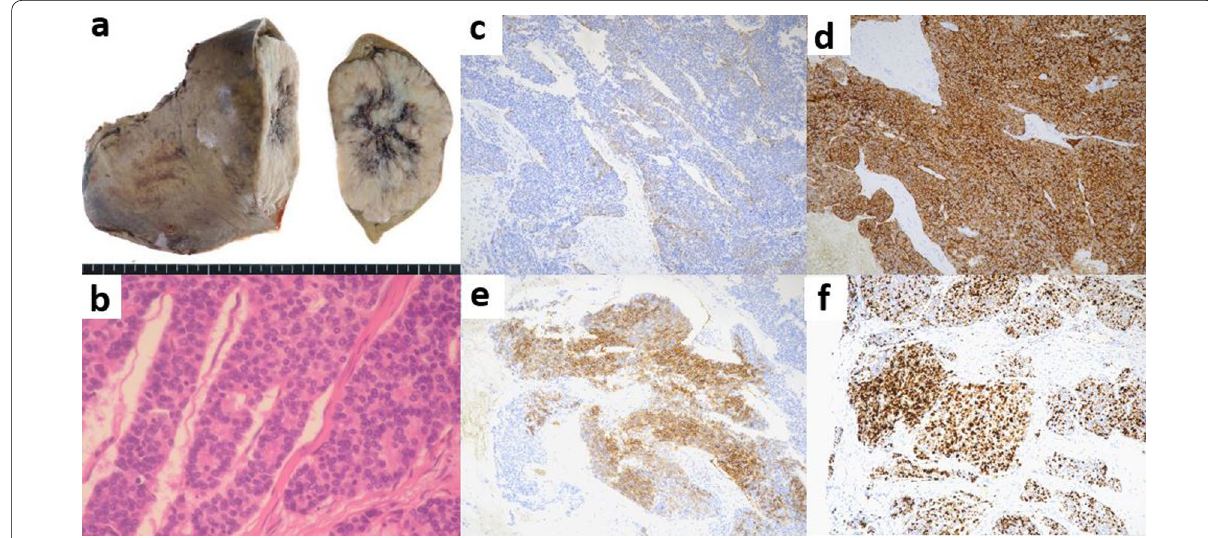
Fig. 3 Macroscopic and histopathological findings of the resected specimen. a The resected specimen was a solid tumor with a diameter of 75 55 42 mm and with a clear border. The resection margins were tumor-free (R0 resection). The non-tumorous portion of the liver was normal. × × b Hematoxylin and eosin staining showed atypical cells with round hyperchromatic nuclei and scanty cytoplasm, forming large and small tumor nests. The tumor was arranged in rosette-like structures around the small blood vessels. Necrosis was identified at the center of the tumor nests, and high mitotic activity was observed in the 28/10 high-power field. c–f Immunohistochemical examination revealed that the tumor cells were diffusely positive for chromogranin A ( c ) and synaptophysin ( d ) and focally positive for CD 56 ( e ). The Ki-67 index was 40% ( f